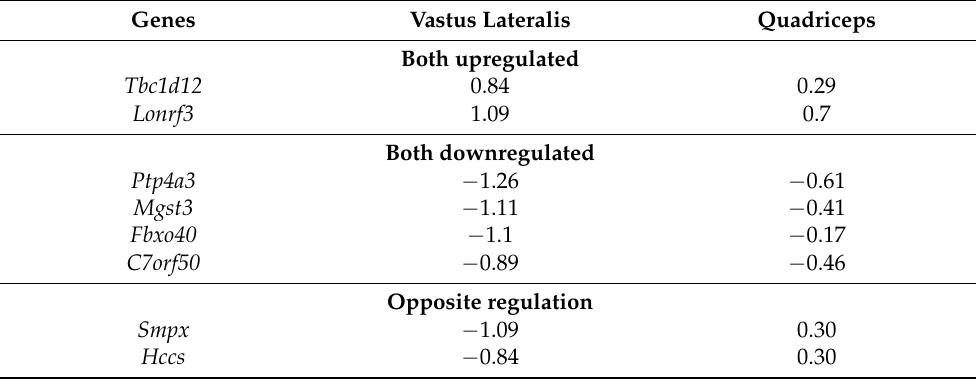
Table 5. DEGs shared between human bedrest VL and space flown mouse quadriceps and direction of expression. Values shown are Log2